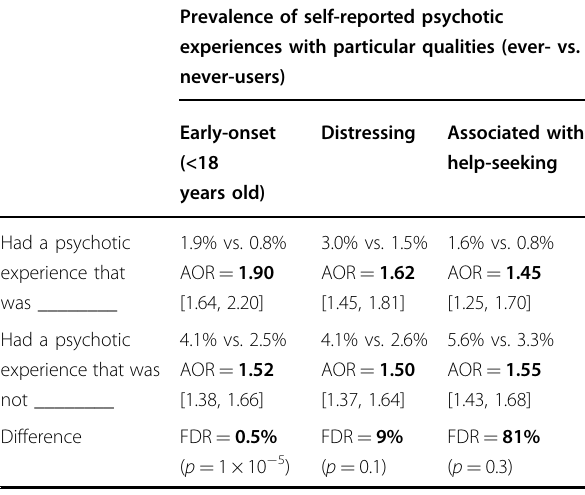
Table 4 Cannabis ever-users report earlier-onset and more distressing psychotic experiences than